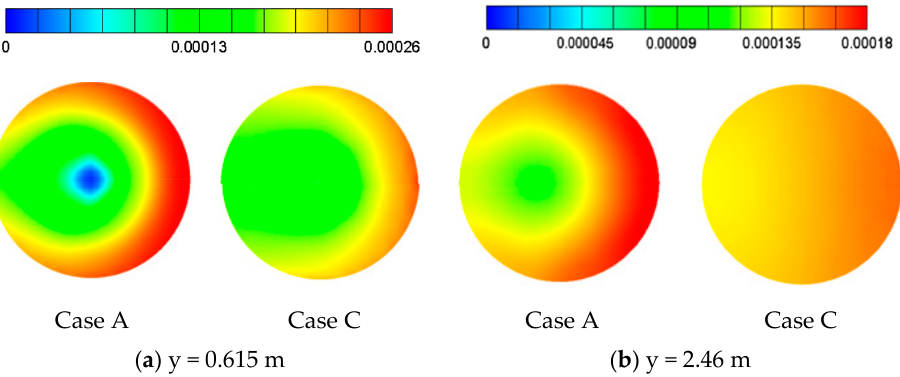
Figure 13. This schematic shows the mass fraction of SO 2 ( Y SO2 ) at different cross sections from top view for Case A and Case